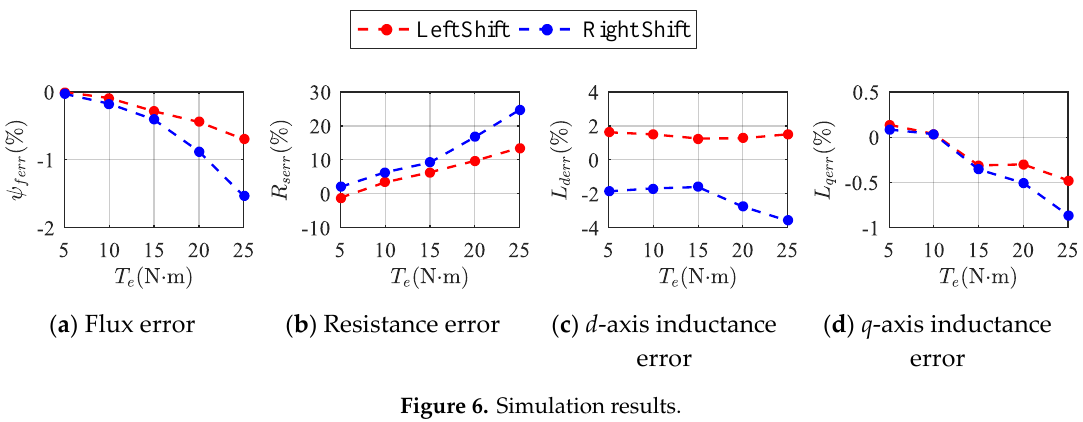
Figure 6. Simulation results.